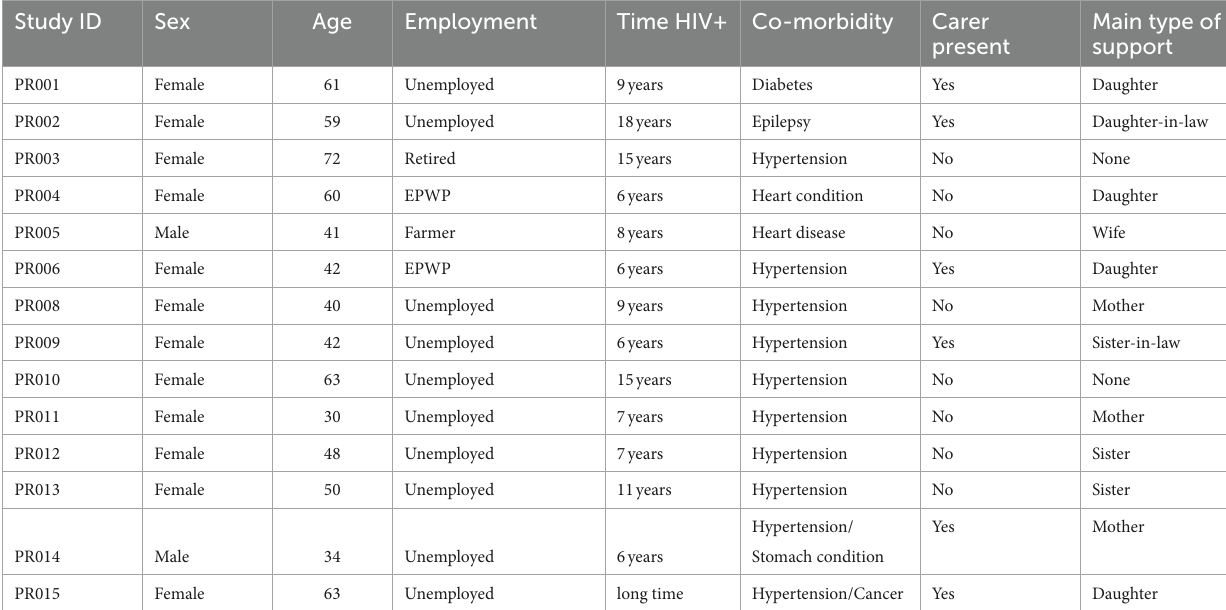
TABLE 3 Participant characteristics Bulungula, Eastern